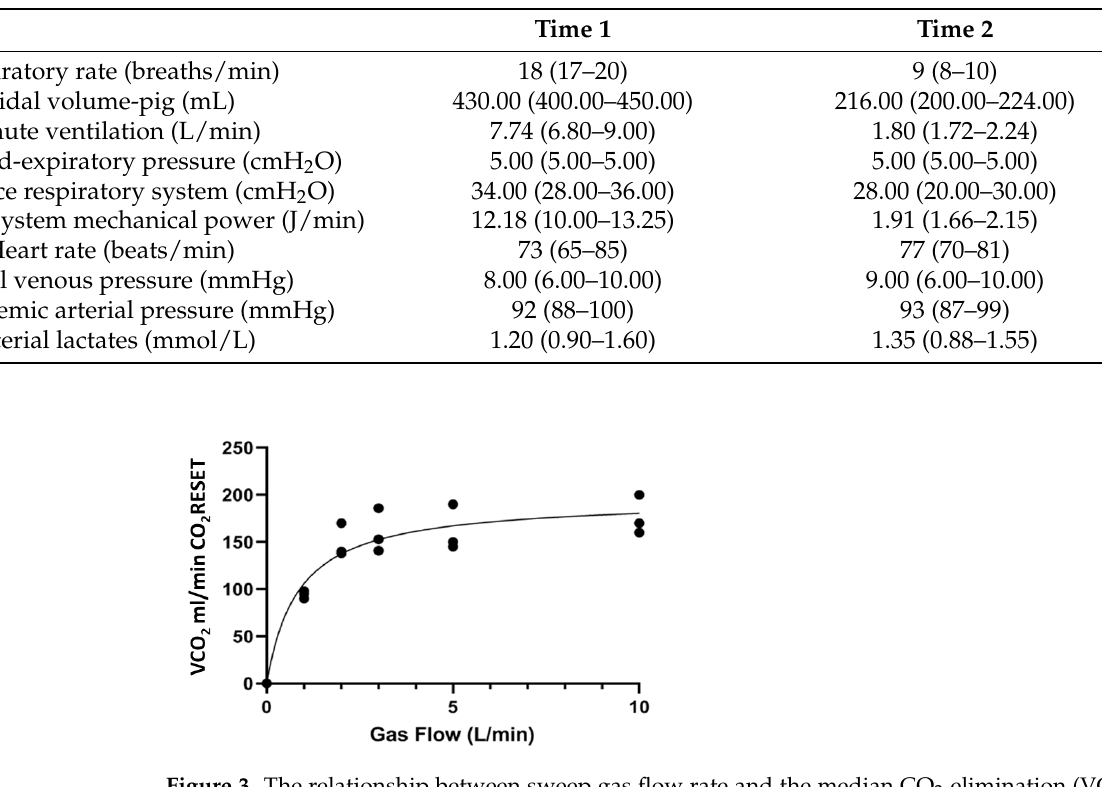
Table 1. Main physiologic variables at baseline (Time 1) and at the beginning of the experiment (Time 2).